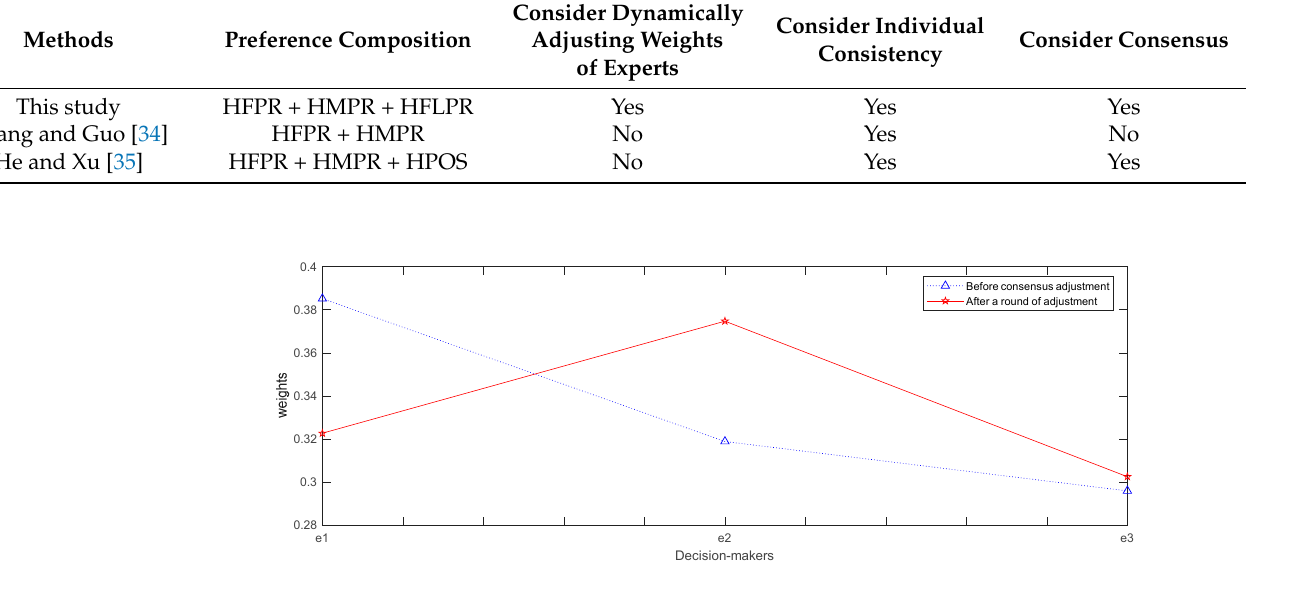
Figure 3. The experts’ weights are dynamically adjusted during the consensus.